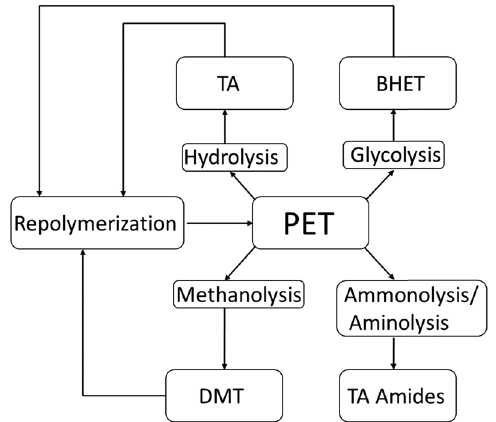
Figure 1: Di ff erent methods of PET chemical recycling paths, adapted from ref. [ 29 ]